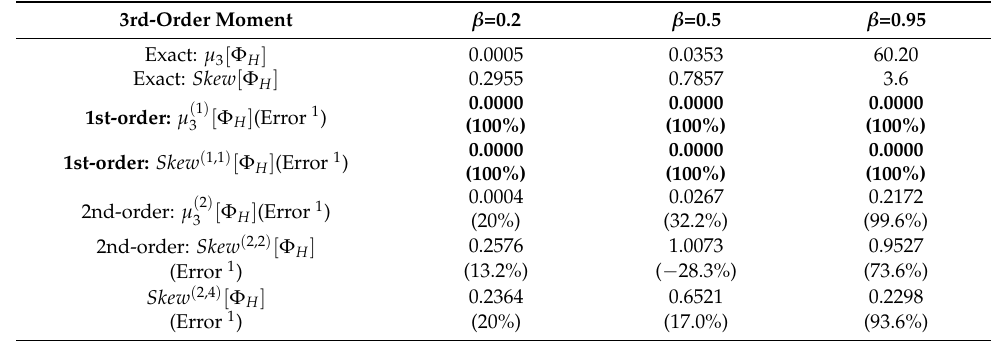
Table 4. Exact and approximate values for the third-order moment and skewness of Φ H ( σ ; E ) .